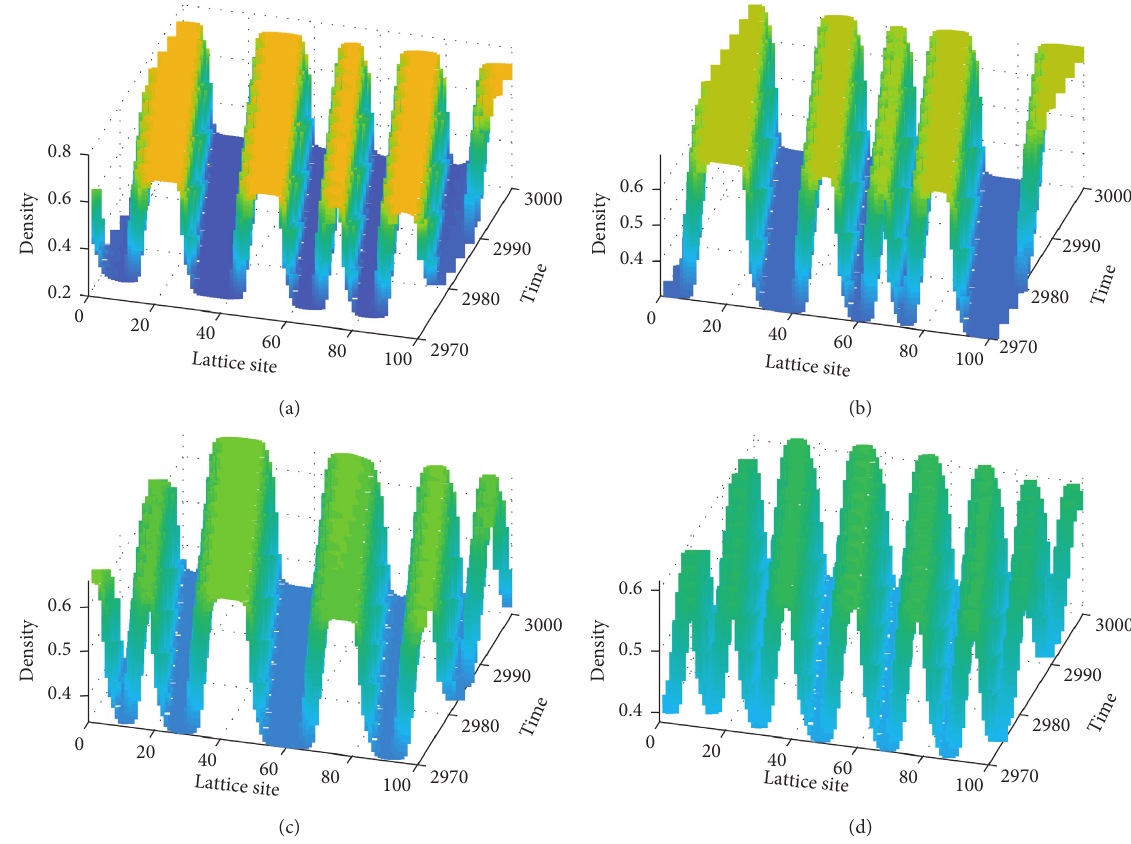
Figure 3: The phase diagram of the model according to different values of parameter p . (a) p � 0, (b) p � 0.1, (c) p � 0.2, (d) p �